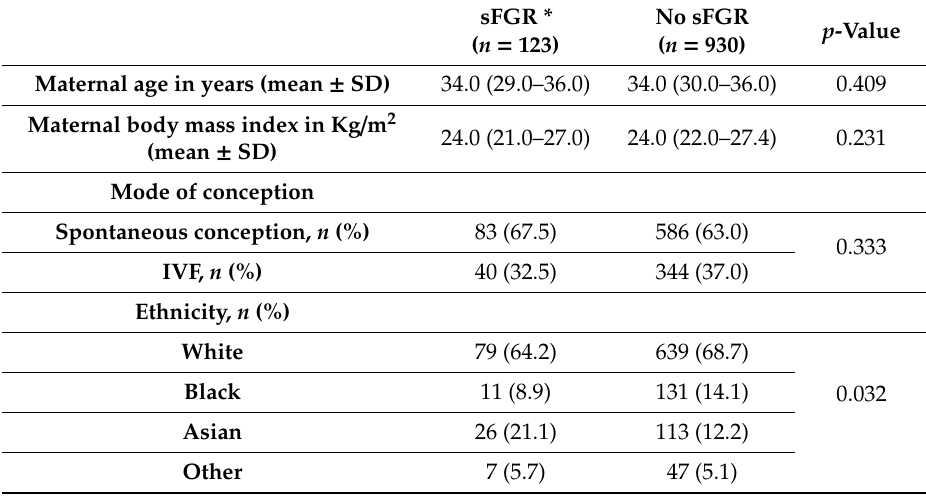
Table 1. Baseline characteristics of the dichorionic diamniotic (DCDA) twin pregnancies, according to whether the pregnancy was complicated by selective fetal growth restriction (sFGR) or